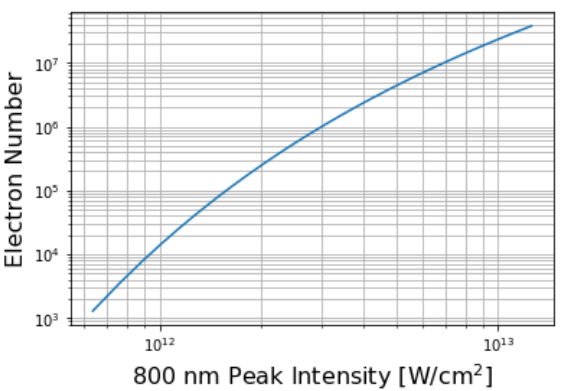
Figure 3. Plot of numbers of electrons emitted as a function of laser intensity in simplified model using Equation